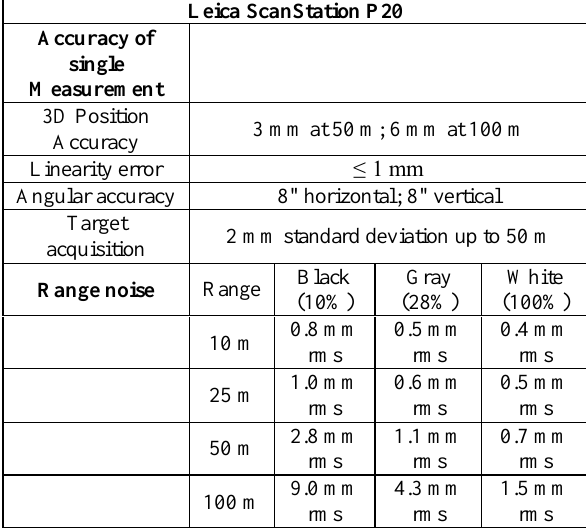
Table 1. System performances of the laser scanner Leica ScanStation P20.